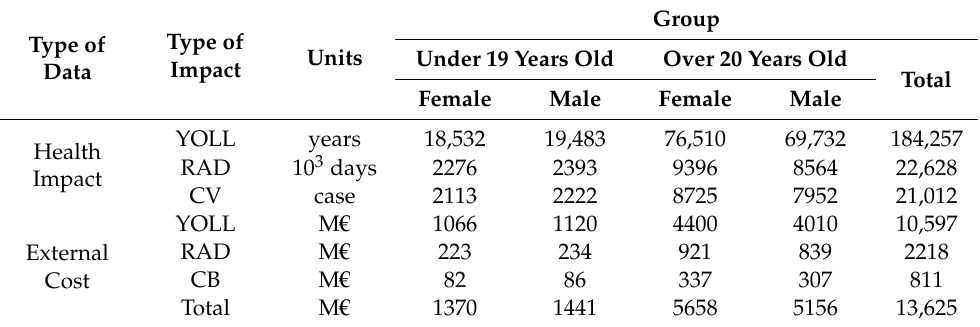
Table 4. The heath impact (YOLL—years of life lost; RAD—restricted activity days; and CB—chronic bronchitis) and external cost for each impact type in Poland associated with PM2.5 in 2050, when the High-RES centralized scenario for the power, road transport, and household and tertiary sectors will be implemented.